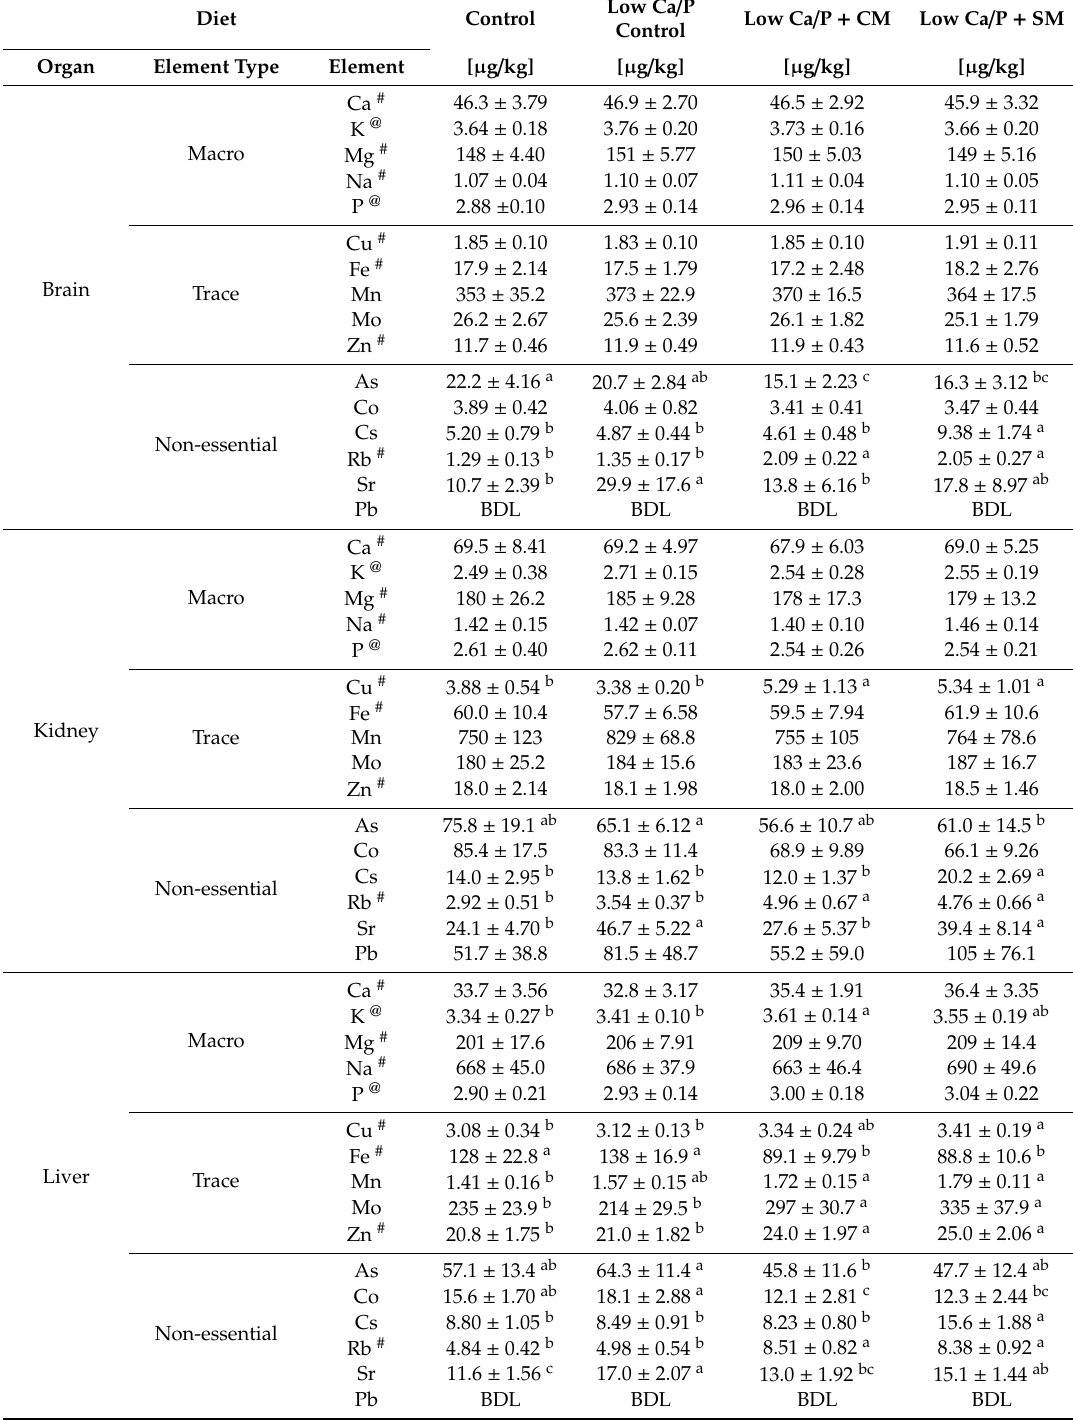
Table 4. Macro, trace, and non-essential mineral concentrations in the organs of rats consuming milk diets ˆ .